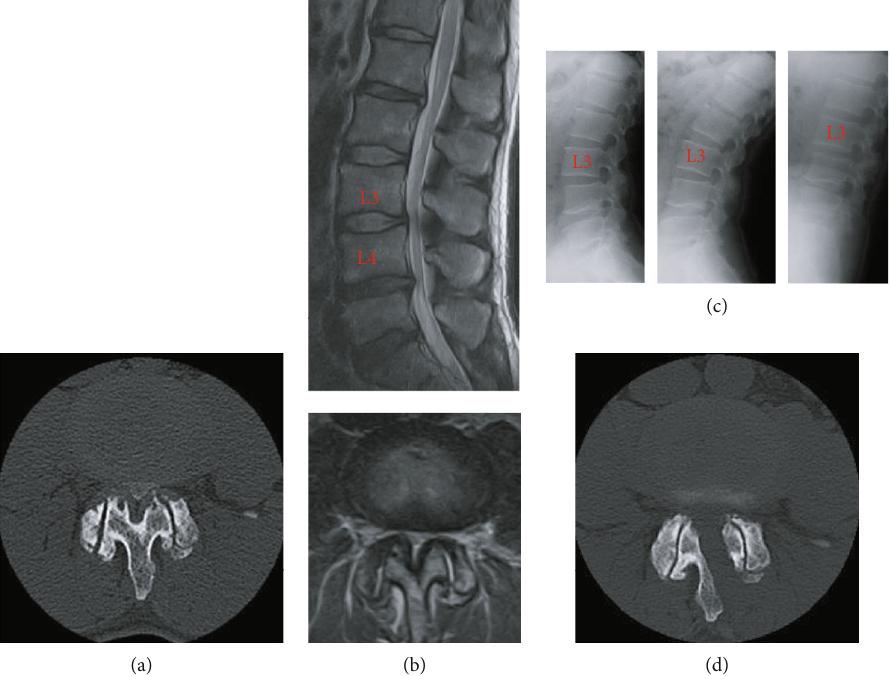
Figure 1: Radiographic images before and after the fi rst surgery. (a) Computed tomography (CT) myelogram before the fi rst surgery showing central canal stenosis at L3/L4. (b) Magnetic resonance (MR) image before the fi rst surgery showing central canal stenosis and facet e ff usions at L3/4. (c) Dynamic X-ray images (neutral, extension, and fl exion position) before the fi rst surgery showing mild L3 spondylolisthesis with a 4-mm slip change. (d) CT image 5 days after the fi rst surgery showing unilateral partial laminectomy at